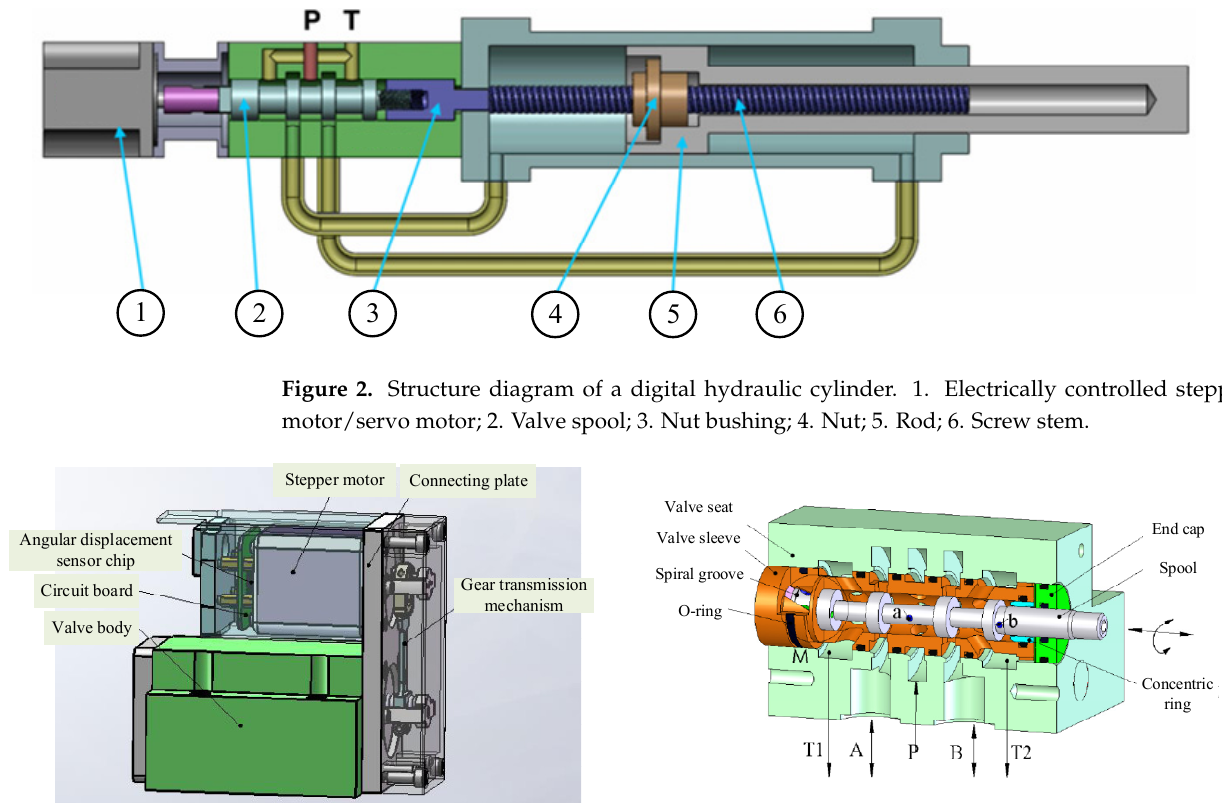
Figure 3. Structure diagram of a large-flow digital development valve. ( a ) Structure diagram of digital valve; ( b ) Sectional view of digital valve.